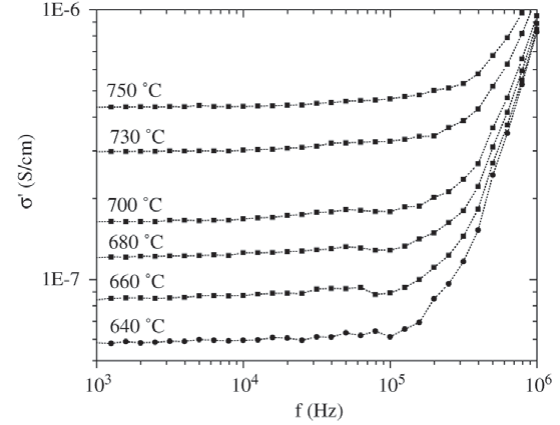
Figure 4. Conductivity σ ’ of BGO single crystal. The plateau at low frequencies accompanied by the dispersion at high frequen- cies is generally related to hopping processes in disordered solids 12 .